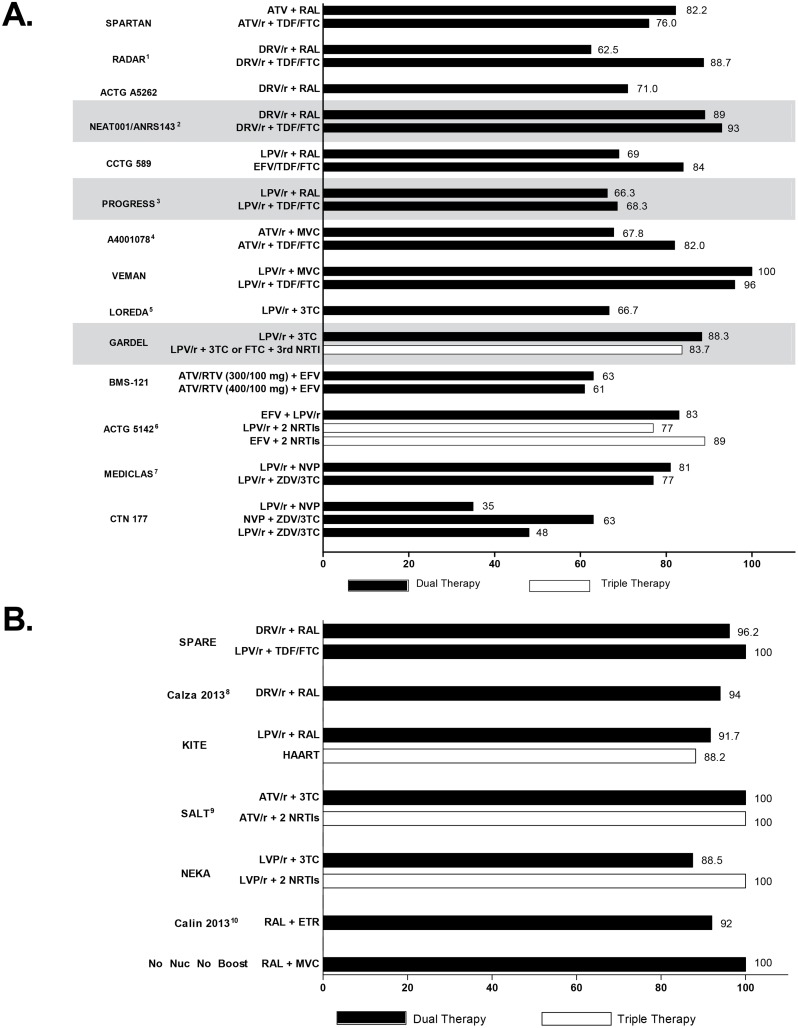
Efficacy of therapy by regimen in A) in ARV-naive, and B) ARV-experienced, virologically suppressed patients.Percentage indicated shows subjects with HIV-1 RNA <50 copies/mL at week 48. Studies that were randomised and sufficiently powered for direct comparison of standard and dual therapy regimens are shaded. 1<48 copies/mL; 2at 96 weeks; 3<40 copies/mL; 4at 96 weeks; 5<48 copies/mL; 6at 96 weeks; 7at 24 months; 8at 12 months; 9at week 24; 10<80 copies/mL. ARV, antiretroviral.